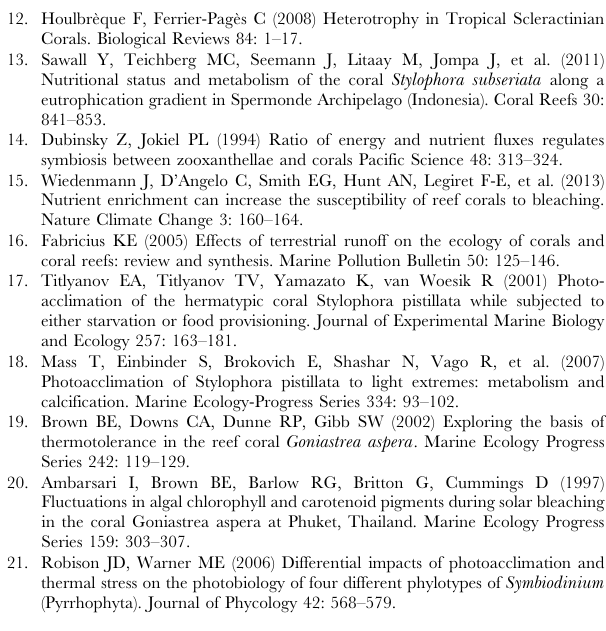
Figure S2 Photographs of 3 representative DGGE gels showing the prominent bands with the corresponding clade names. Figure S3 P-I curves at all sites from N (top) to S (bottom) in September 2011 and March 2012. Mean 6 SE. Figure S4 NPQ versus PAR at all sites from N (top) to S (bottom) in September 2011 and March 2012. Mean 6 SE. Table S1 NASA-derived environmental data at all sites (1–6, North – South) in September 2011(Sep11) and March 2012 (Mar12). Detailed description of data is provided within the table. Table S2 Zooxanthellae properties at all sites (1–6, North – South) in September 2011(Sep11) and March 2012 (Mar12). Photo-collecting pigments: sum of chlorophyll a and c2 and peridinin. N= 6. Mean ( 6 SE). Table S3 Zooxanthellae performance at all sites (1–6, North – South) in September 2011(Sep11) and March 2012 (Mar12). Net photosynthesis and non-photochemical